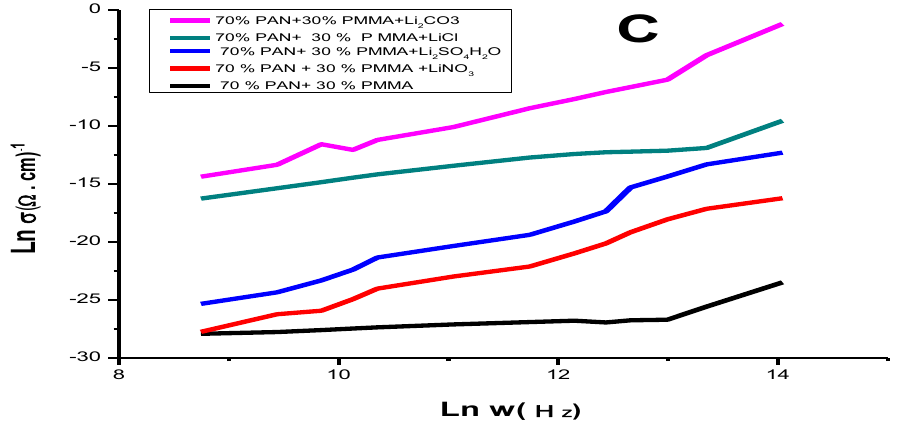
Figure 1 c: Variation of Ln σ (ω) with Ln(ω) for (70%PAN/30%PMMA) and doped a.c